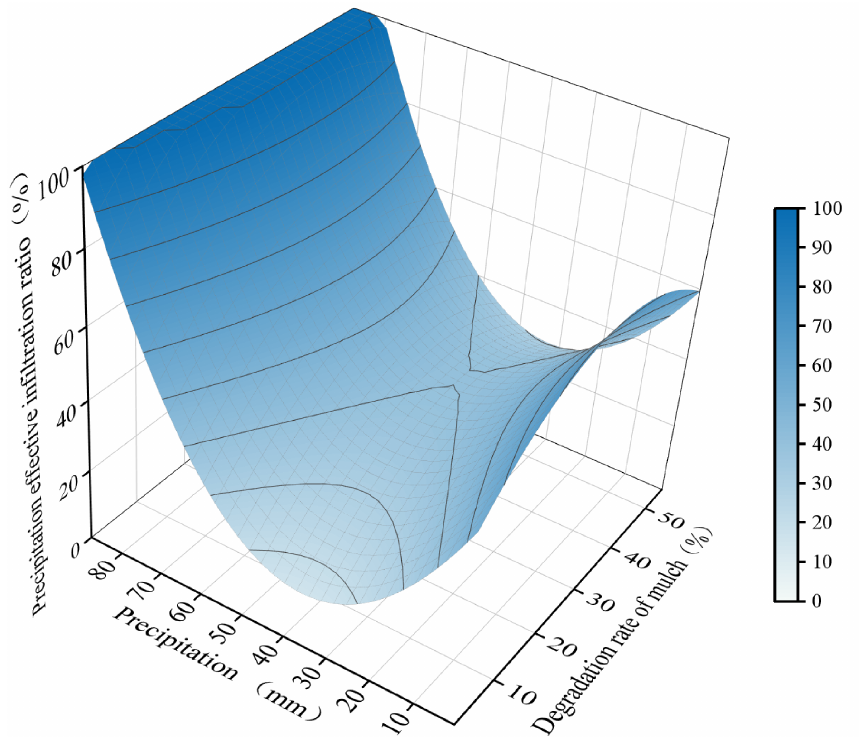
Figure 4. Interaction of precipitation and damage rate on precipitation effective infiltration ratio. We set the precipitation range to 1–84 mm, its step length to 2.8 mm, the degradation rate to 1–55%, and its step length to 1.8%. We then drew a 3D surface map by substituting these values into the regression equation (Figure 4). The lowest ratio of precipitation effec- tive infiltration occurred when precipitation was 24–37 mm. After precipitation reached 89.21 mm, the mulch no longer affected precipitation utilization in the mulching area. As the degradation rate of biodegradable mulch increased, the precipitation required for the minimum ratio of precipitation effective infiltration gradually decreased. For a degrada- tion rate of 1%, the minimum rate of precipitation effective infiltration corresponded to precipitation of 35.69 mm. As the degradation rate increased to 15.53%, the minimum rate of precipitation effective infiltration corresponded to precipitation of 25 mm. When the degradation rate was 36.64%, the minimum ratio of precipitation effective infiltration corresponded to 10 mm of precipitation. During the 3 y study period, 56 precipitation events occurred—of which only 7 presented precipitation greater than 25 mm—and the West Liaohe Plain experienced mainly light and moderate precipitation. Therefore, the results suggest that the degradation rate of the biodegradable mulches reached 36.64% when the rainy season